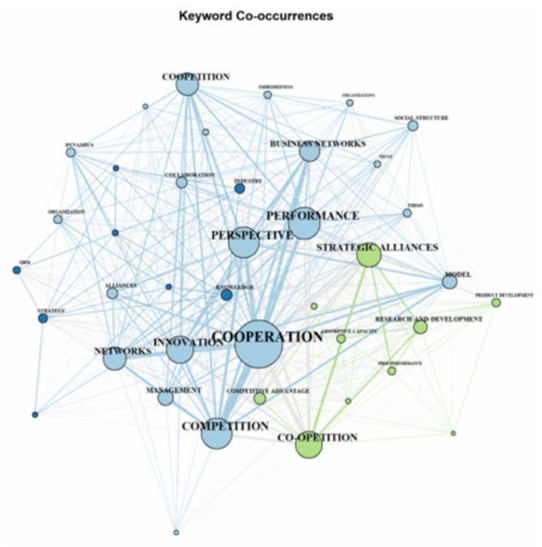
Figure 3. Co-word analysis through keyword co-occurrences.